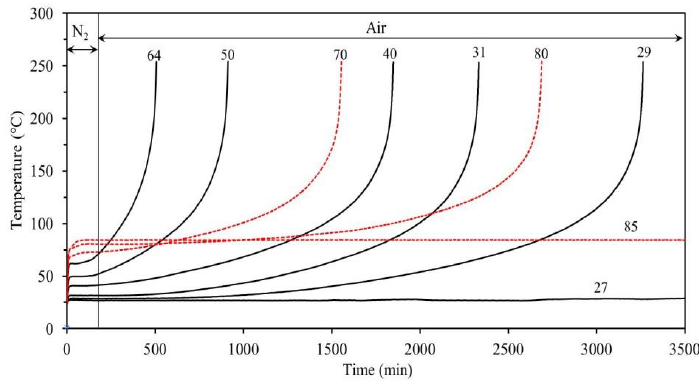
Figure 12. SIT curves for SSSR in the room-temperature to 100 °C range.